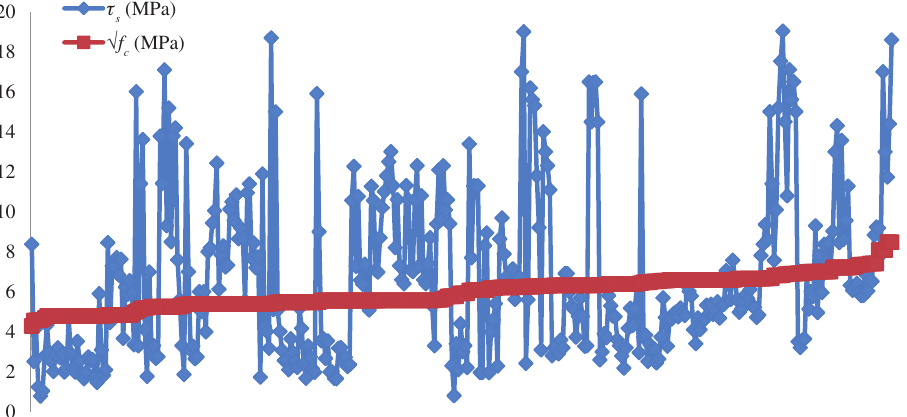
Figure 19: Change in the bond strength of FRP bars in concrete with changing square root of concrete compressive strength.